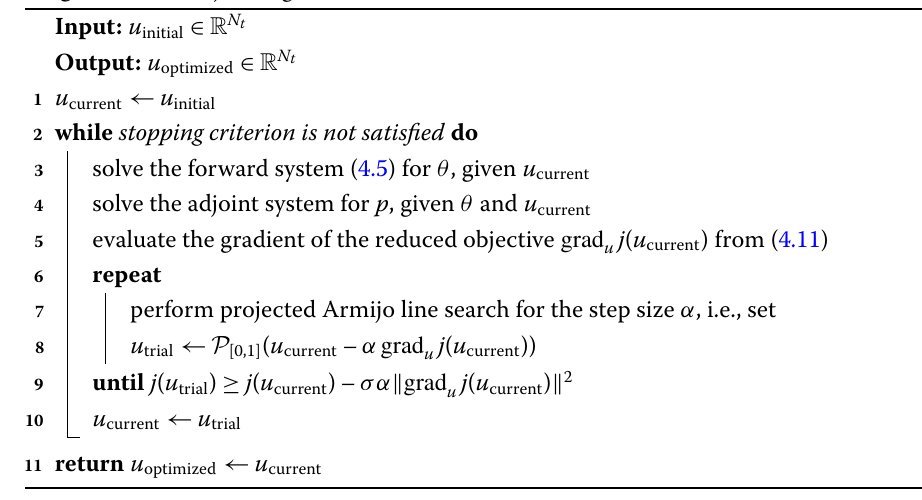
Algorithm 1: Projected gradient descent